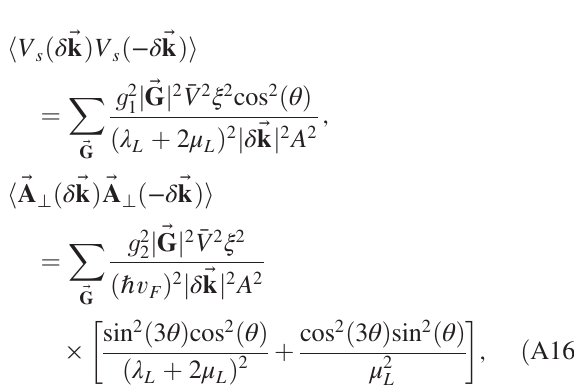
FIG. 6. Correlation of the inverse mobility and ð n (cid:1) Þ 2 for a number of different bilayer graphene flakes on different